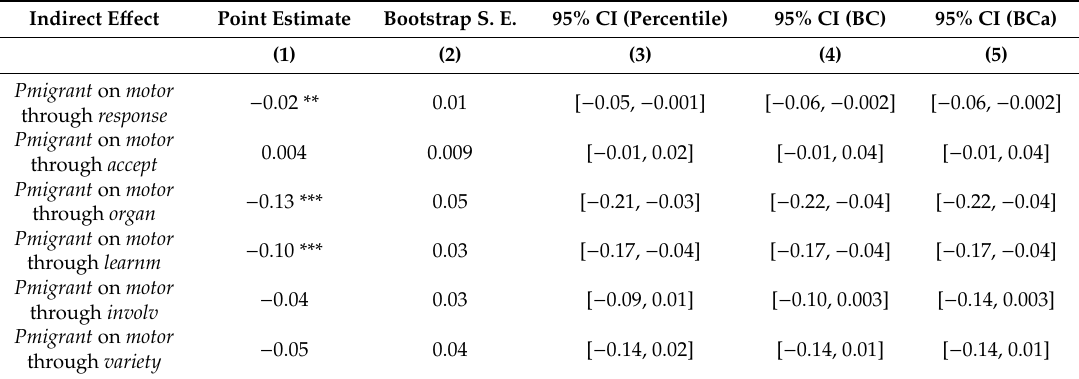
Table 6. Estimates of indirect e ff ects of parental migration on motor development through di ff erent dimensions of home environment.